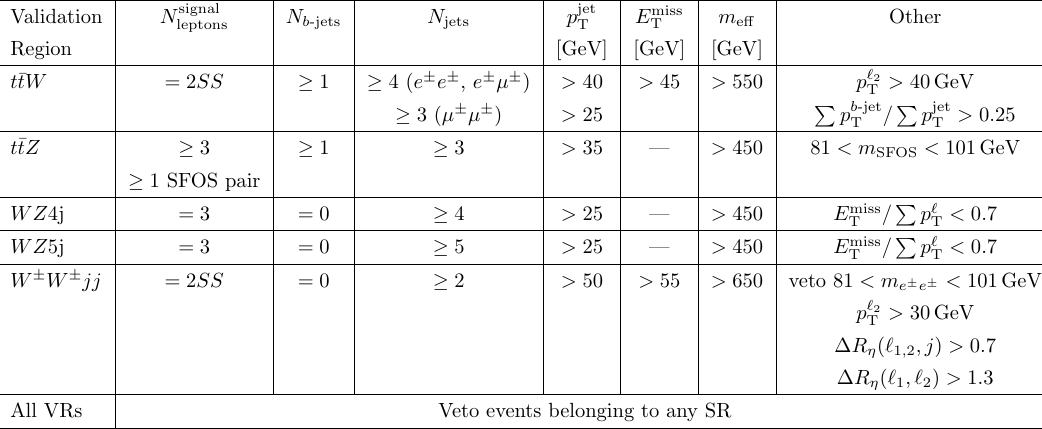
Table 3. Summary of the event selection in the validation regions (VRs). Requirements are placed on the number of signal leptons ( N signal ), the number of b -jets with p T > 20 GeV ( N b -jets ) or the leptons number of jets ( N jets ) above a certain p T threshold ( p jet ). The two leading- p T leptons are referred T to as ‘ 1 ; 2 with decreasing p T . Additional requirements are set on E miss T